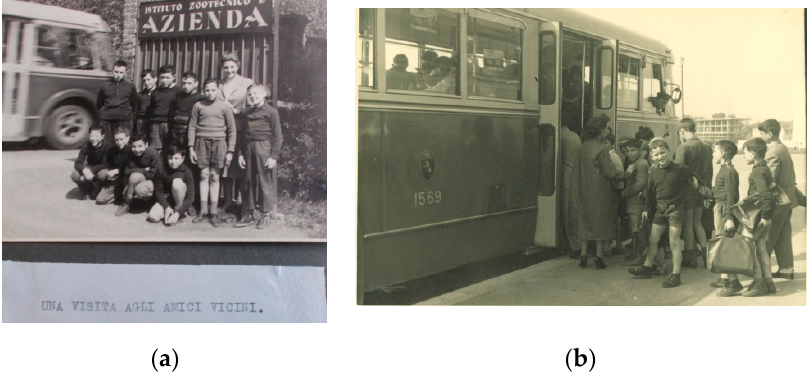
Figure 3. ( a ) Pupils of the Physician Pedagogic School visiting the Bonafus institute (ASPG, file 3492); ( b ) special trams to go to school (ASPG, file